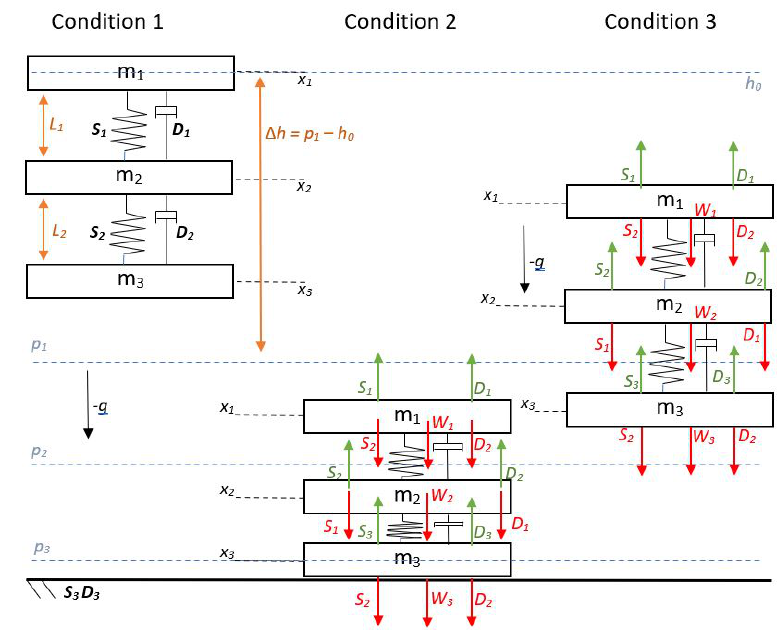
Figure 5. System